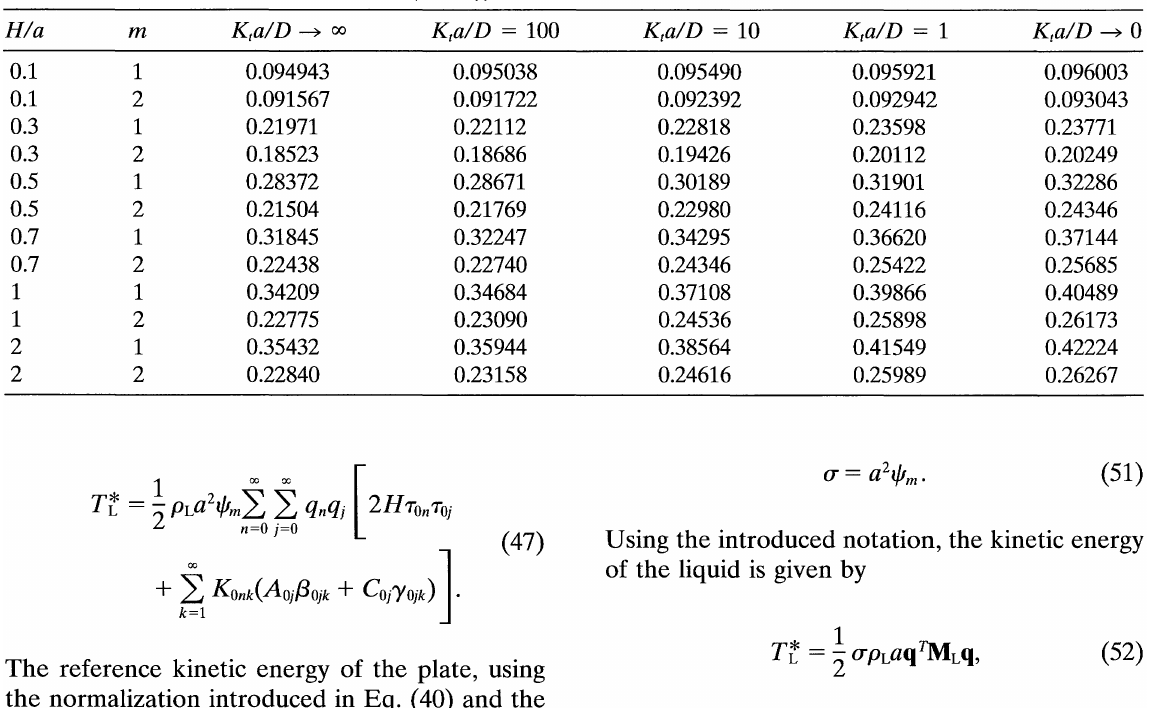
Table 4. NA VMI Factors for Supported Circular Plates with Elastic Moment Edge Constraint, Asymmetric Modes with No Internal Circular Nodes (n = 0), and v =